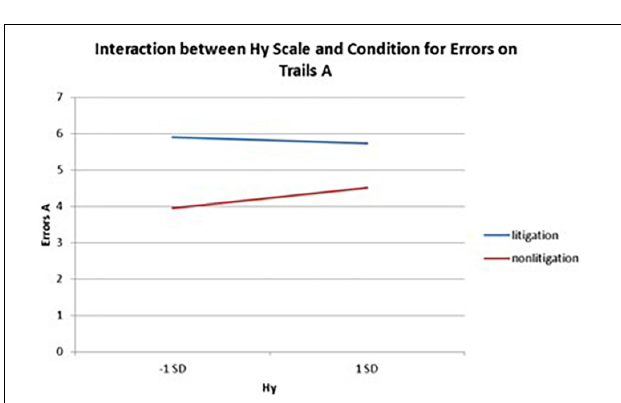
FIGURE 6 | Plotting the interaction between Hy scale and condition when predicting errors on Trails A of the TMT.